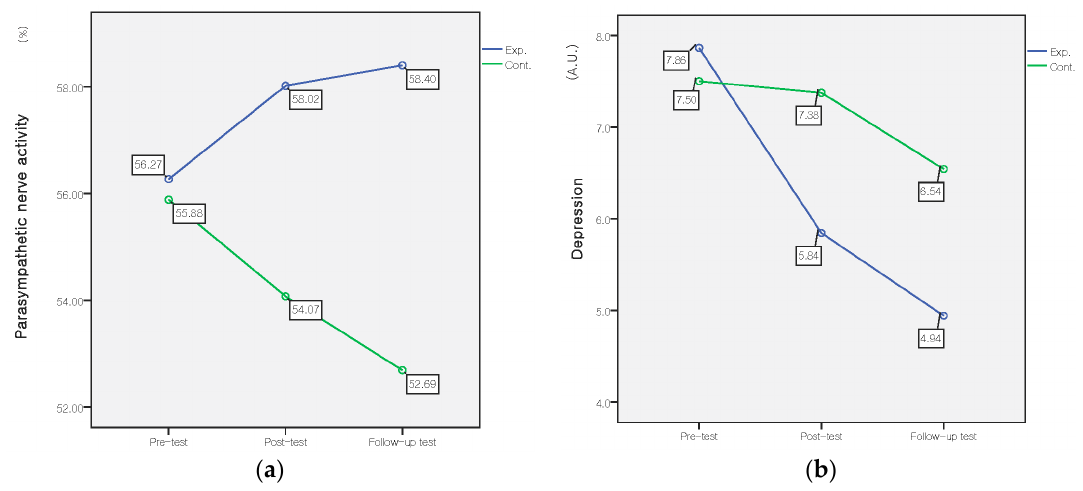
Figure 4. Comparison of the parasympathetic nerve activity ( A ) and mean depression score ( B ) between the experimental and control groups in pre-, post-, and follow-up